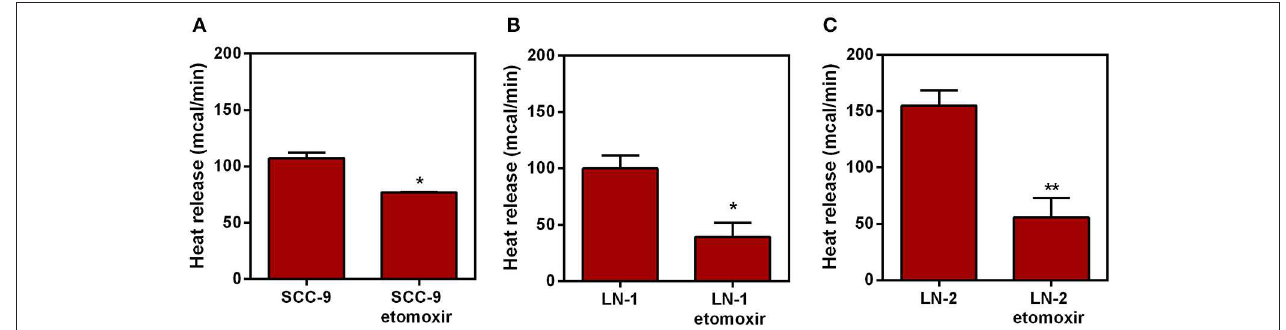
FIGURE 8 | Effect of etomoxir on the heat release by human oral squamous carcinoma cells SCC-9, LN-1 and LN-2 cells. The bars represent the release of total heat of living cells in 35min of experiment. (A) Heat release by SCC-9 cells untreated and treated with 300 µ M of etomoxir; (B) Heat release by LN-1 cells untreated and treated with 300 µ M of etomoxir. (C) Heat release by LN-2 cells untreated and treated with 300 µ M of etomoxir. Values were expressed as mean ± SEM. * p < 0.05; ** p <